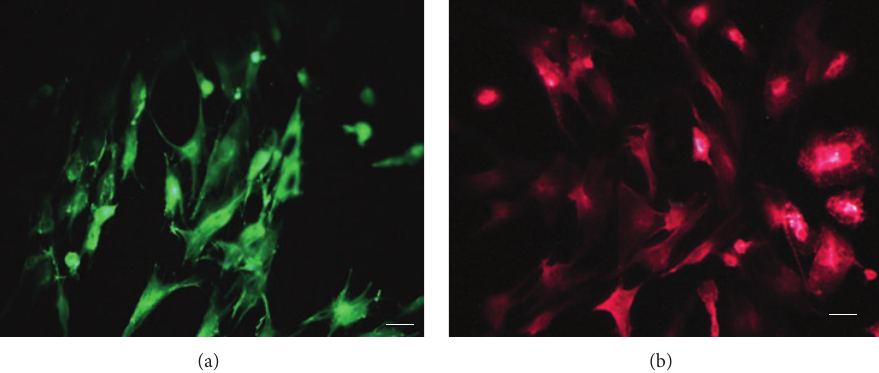
Figure 5: Mesenchymal cells of group 2 underwent immunoflorescence GFAP/Alexa 488 (a) and OX-42/TRITC (b) antibody (10x). Scale: 100 𝜇